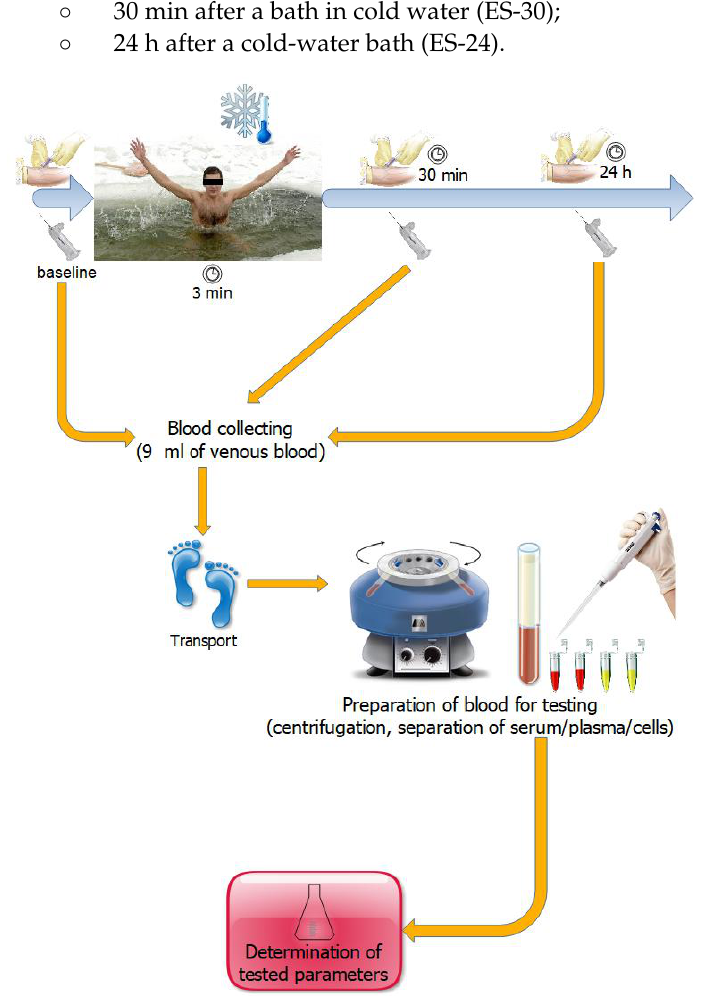
Figure 2. Collecting material for research in each of the two stages of the experiment. The material collected for biochemical tests included venous blood specimens col- lected in a vacuum system from the basilic vein. For serum collection, blood samples were collected into tubes containing a clotting activator (SiO 2 ) and a separating gel. Determina- tion of parameters in erythrocytes and blood plasma was performed using blood samples collected into test tubes containing the anticoagulant dipotassium edetate (K 2 EDTA). TBARS concentration and SOD, CAT, and GPx activities were determined via spec- trophotometric methods using a Cary 60 UV-Vis spectrophotometer (Agilent Technolo- gies, Santa Clara, California, USA). Concentrations of vitamins A and E were determined using high-performance liquid chromatography (HPLC) with the ProStar System kit with a fluorescence detector (Varian, Palo Alto, California, USA). In contrast, the concentrations of 4-HNE and 8-iso- PGF2α were determined using commercial diagnostic kits based on the immunoenzymatic method (ELISA) using a SPECTROstar Nano plate spectrophotom- eter (BMG LABTECH, Ortenberg, Germany). All tested parameters were analyzed in du- plicate, and the mean values of the tests were given as a result. 2.3. Determination of the Activity of Antioxidant Enzymes in Erythrocytes SOD activity in erythrocytes was determined using the method of Misra and Fri- dovich [20]. This method evaluates the enzyme ’ s inhibition of the auto-oxidation reaction of adrenaline to adrenochrome in an alkaline environment (pH 10.2). SOD activity was expressed in U/g Hb. CAT activity was determined using the Beers and Sizer method [21]. The principle of the method is based on lowering the absorbance of the hydrogen peroxide (H 2 O 2 ) solution decomposed by the enzyme. CAT activity was expressed in IU/g Hb. GPx activity was determined according to the method of Paglia and Valentine [22]. This